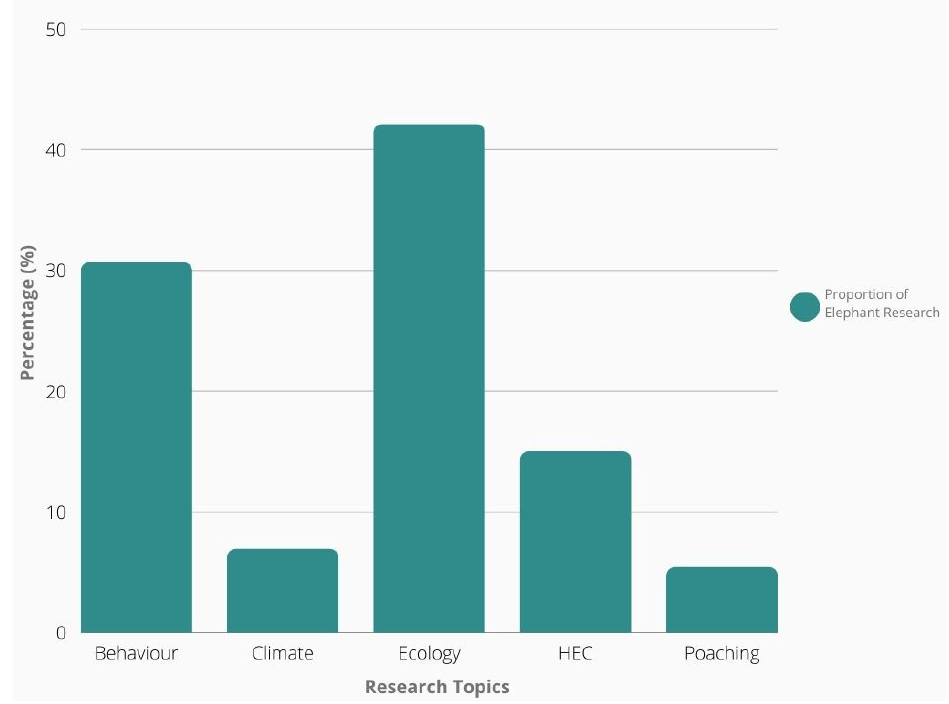
Figure 6. Percentage of total elephant research to which each topic contributes.